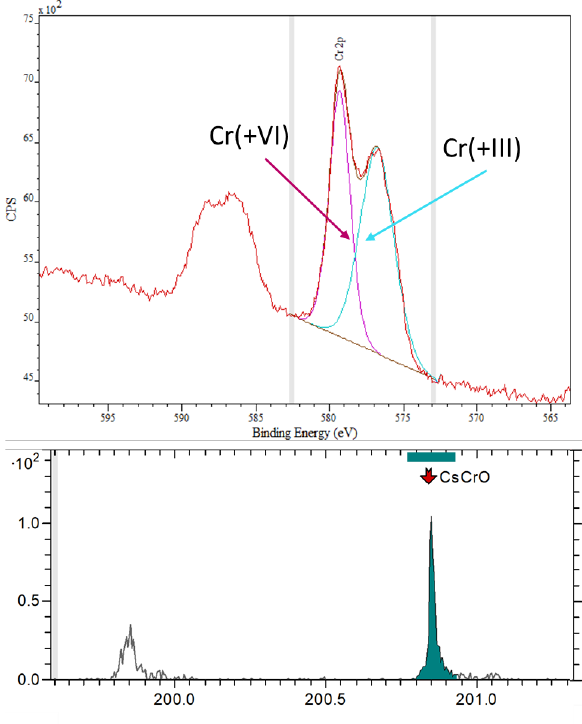
Figure 2: Cr 2p XPS and ToF SIMS spectra of CsI deposited on SS coupon after revaporization at